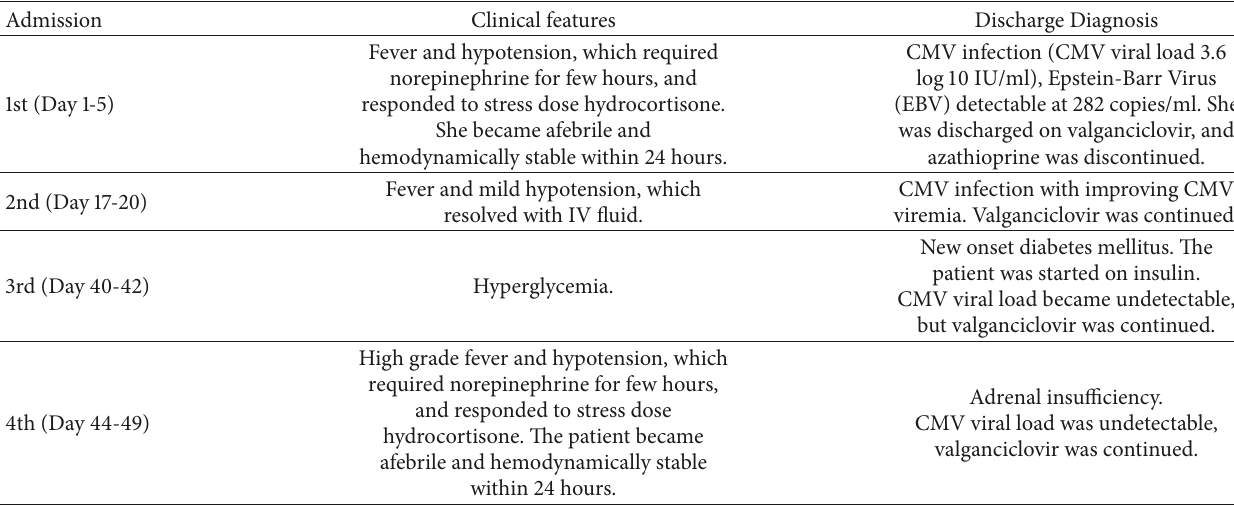
Table 1: Summary of